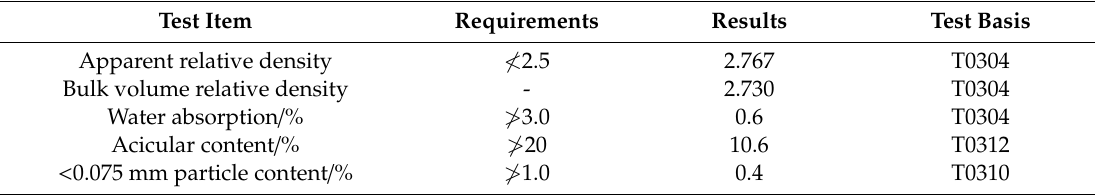
Table 4. Physical properties of